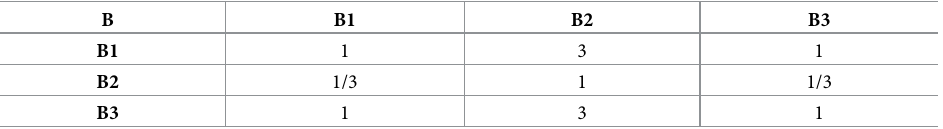
Table 9. Judgment matrix of the criteria for the assessment of water resources. B